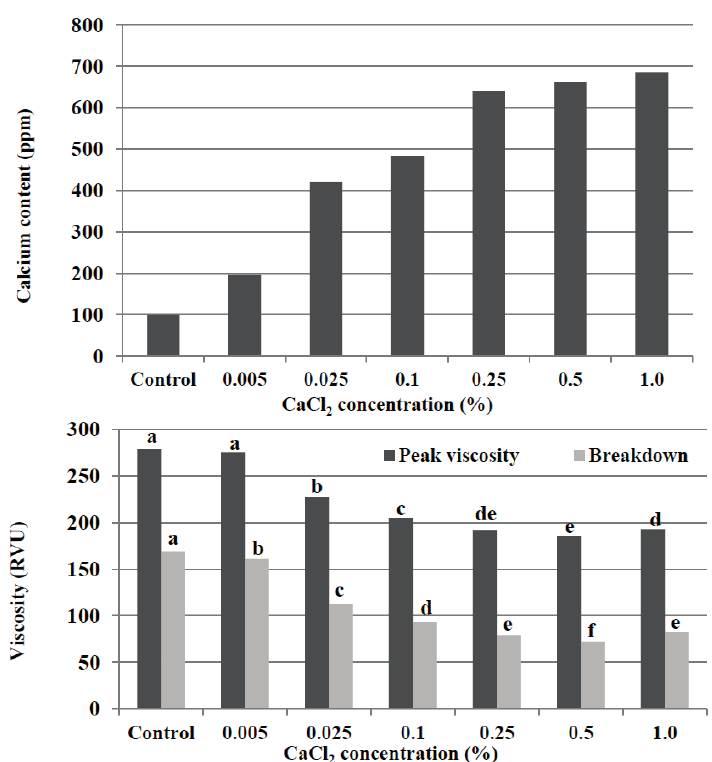
Figure 2. The calcium content and RVA pasting properties of the potato starches treated with CaCl 2 aqueous solution. For each RVA parameter (peak viscosity or breakdown), bars labeled with the same letter are not significantly different ( p <